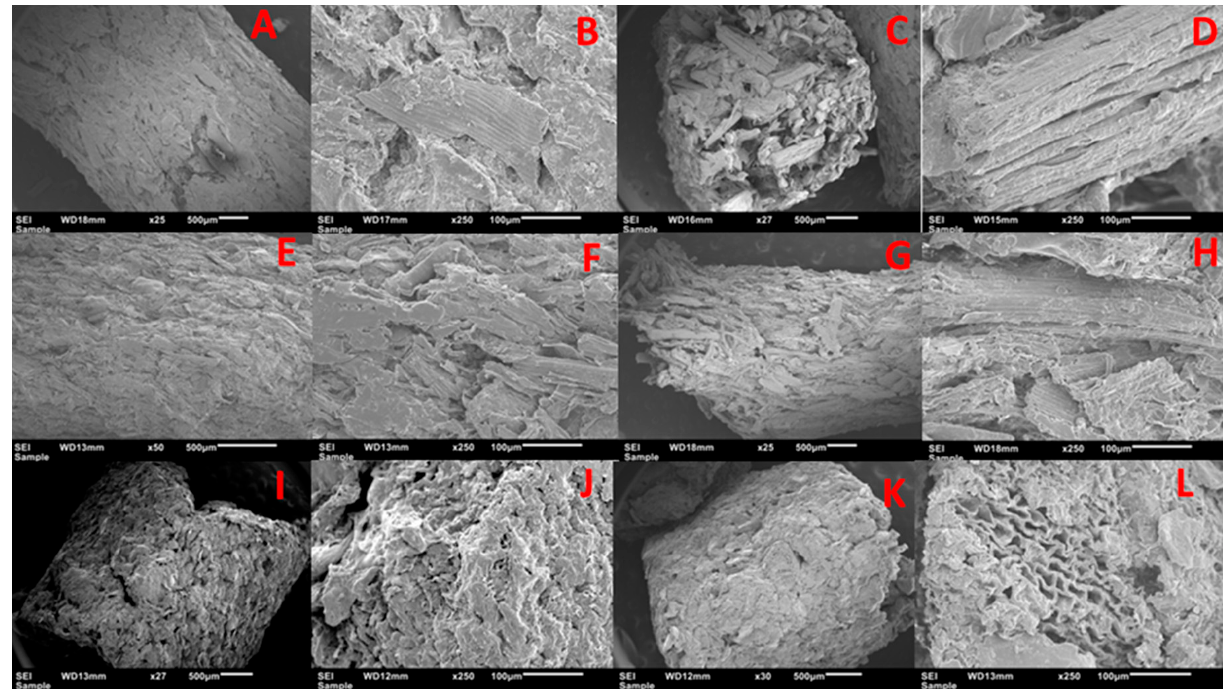
Figure 2. Low magnification images for 60 wt.% pellet materials with oat hulls ( A , B ), crosslinked oat hull pellets ( C , D ), torrefied wheat straw ( E , F ), crosslinked wheat straw pellets ( G , H ), spent coffee grounds ( I , J ), and crosslinked spent coffee pellets ( K , L